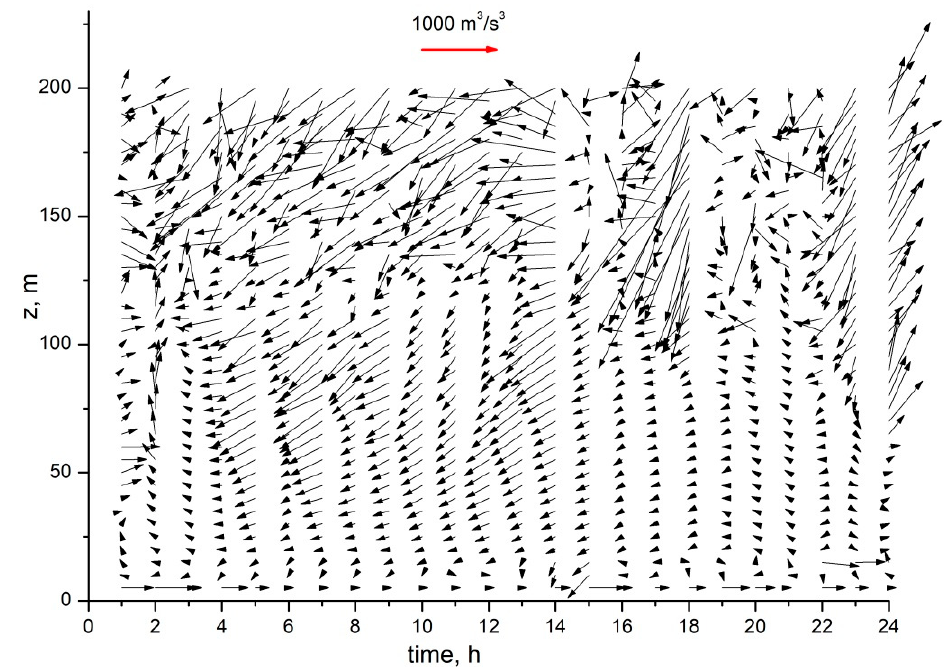
− j ( z , t ) (northern    , z t j (northern di ‐